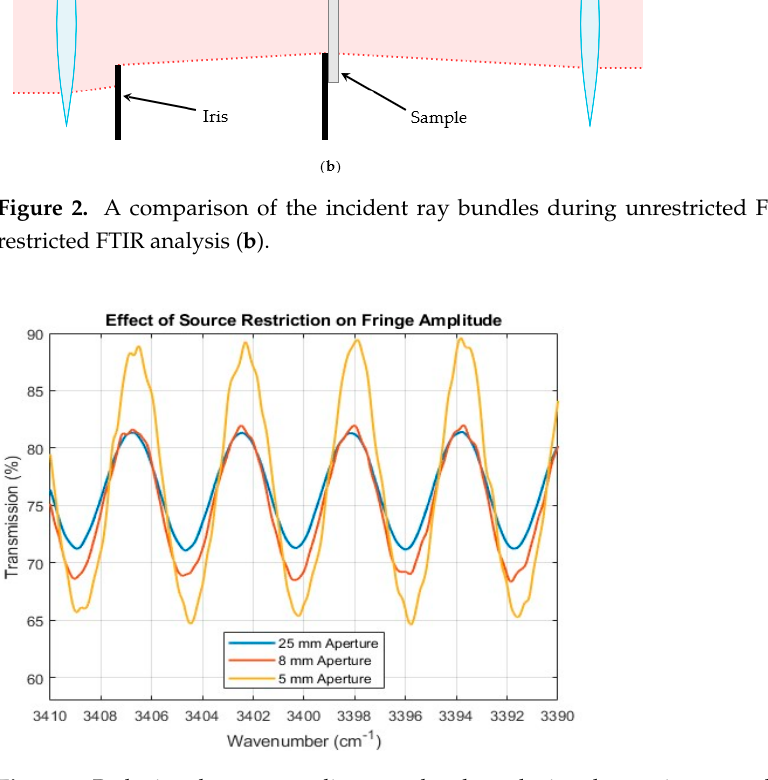
Figure 2. A comparison of the incident ray bundles during unrestricted FTIR analysis ( a ) and re- stricted FTIR analysis ( b ).